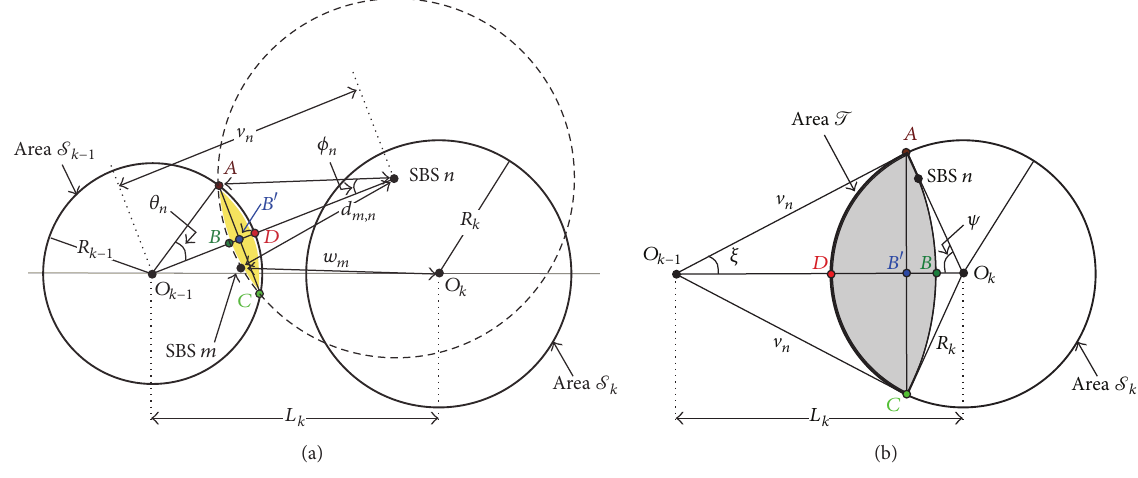
Figure 4: An example illustration to derive the PDF of 𝑑 𝑚,𝑛